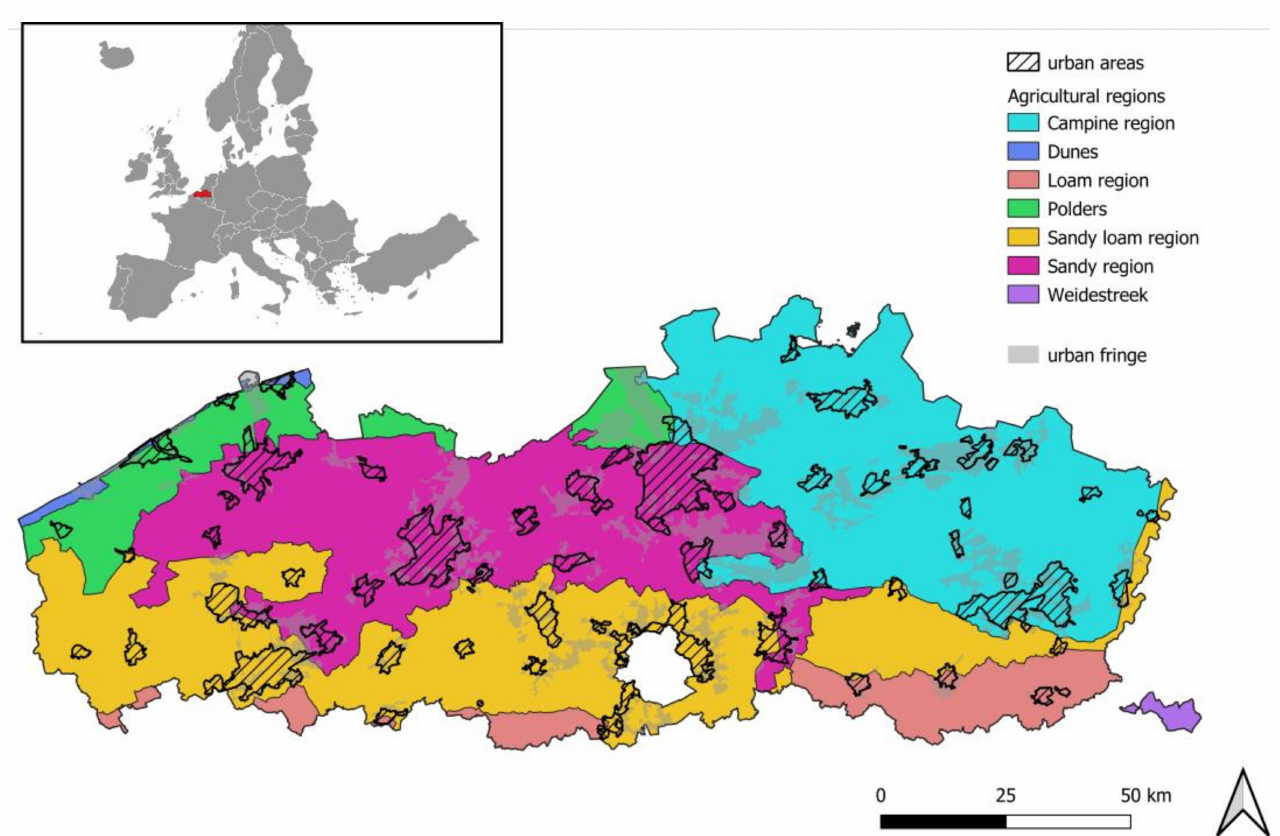
Figure 1. Map of the seven agricultural regions, urban (shaded area) and rural (non-shaded area) areas in Flanders. The urban fringe (as defined by [22]) is visualized in grey for reference. Flanders is highlighted in red on the reference map of Europe in the left upper